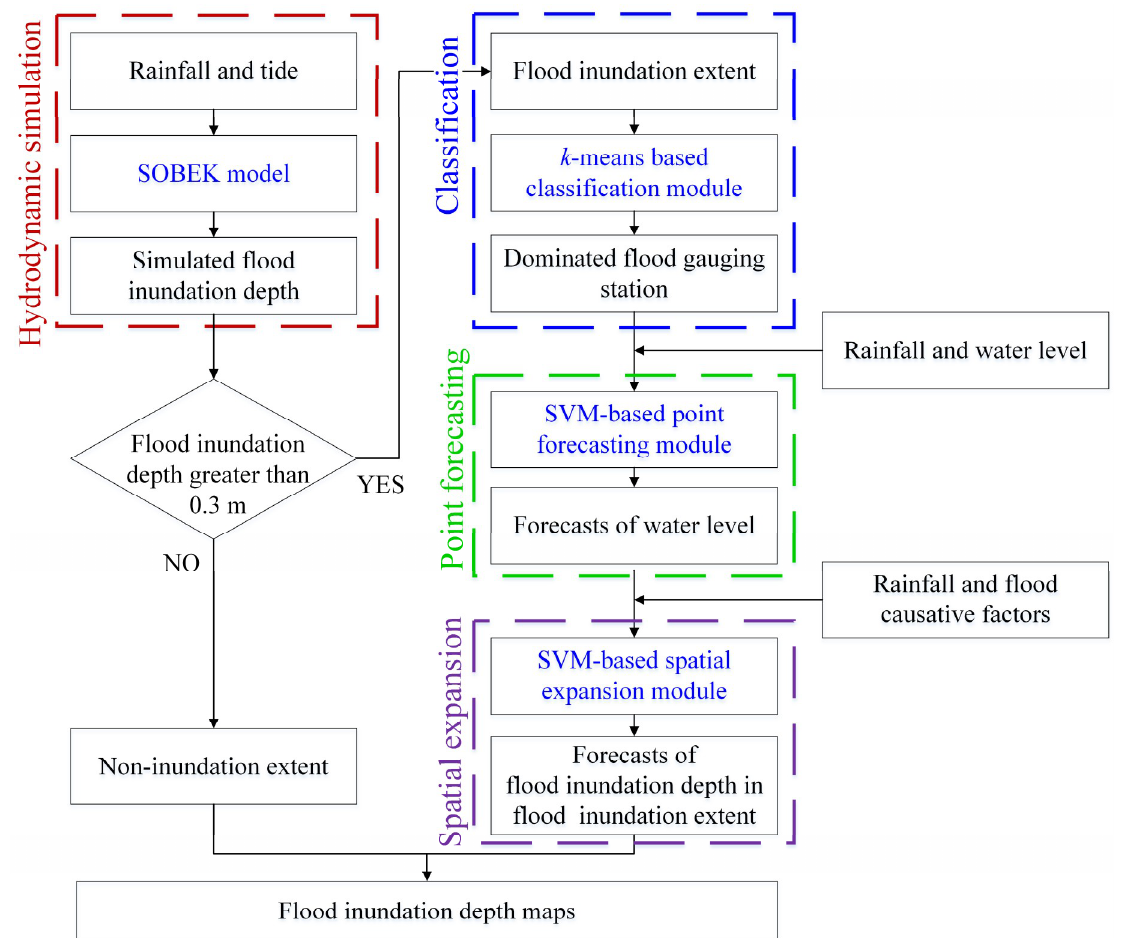
Figure 3. Flowchart of the proposed model.